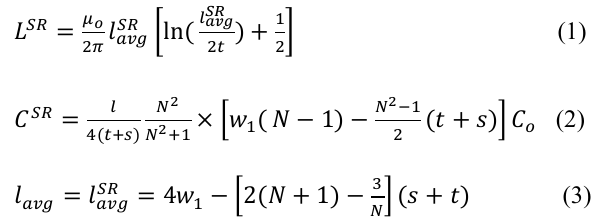
Figure 11: S-parameter simulation result of SDRA antennas array with copper parasitic